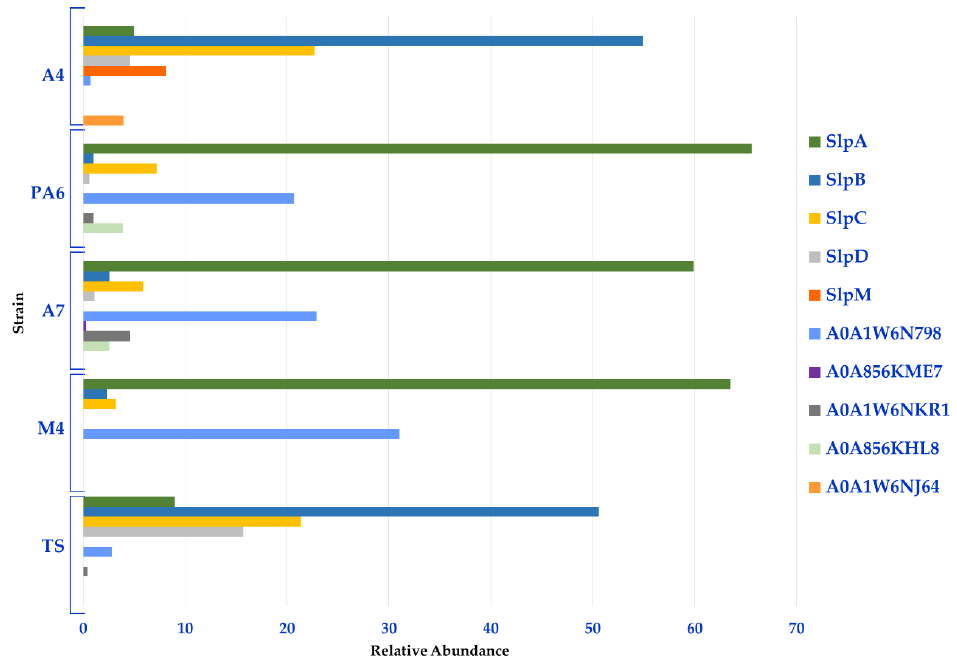
Figure 3. Relative distribution of the Slps identified in each L. brevis strain.